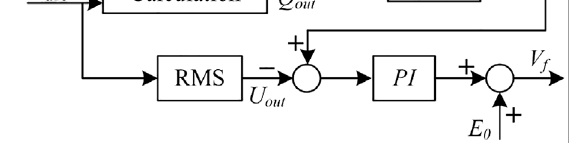
FIGURE 3 Control system of the automatic voltage regulator.